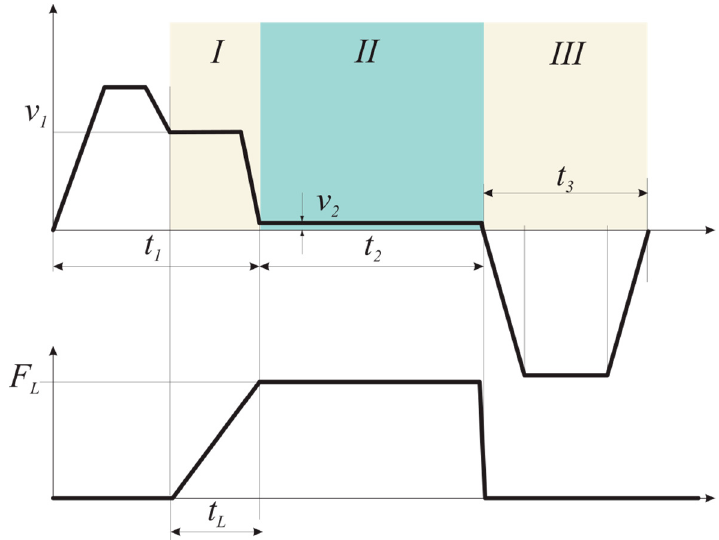
Figure 2. Simple load cycle for basic consideration.